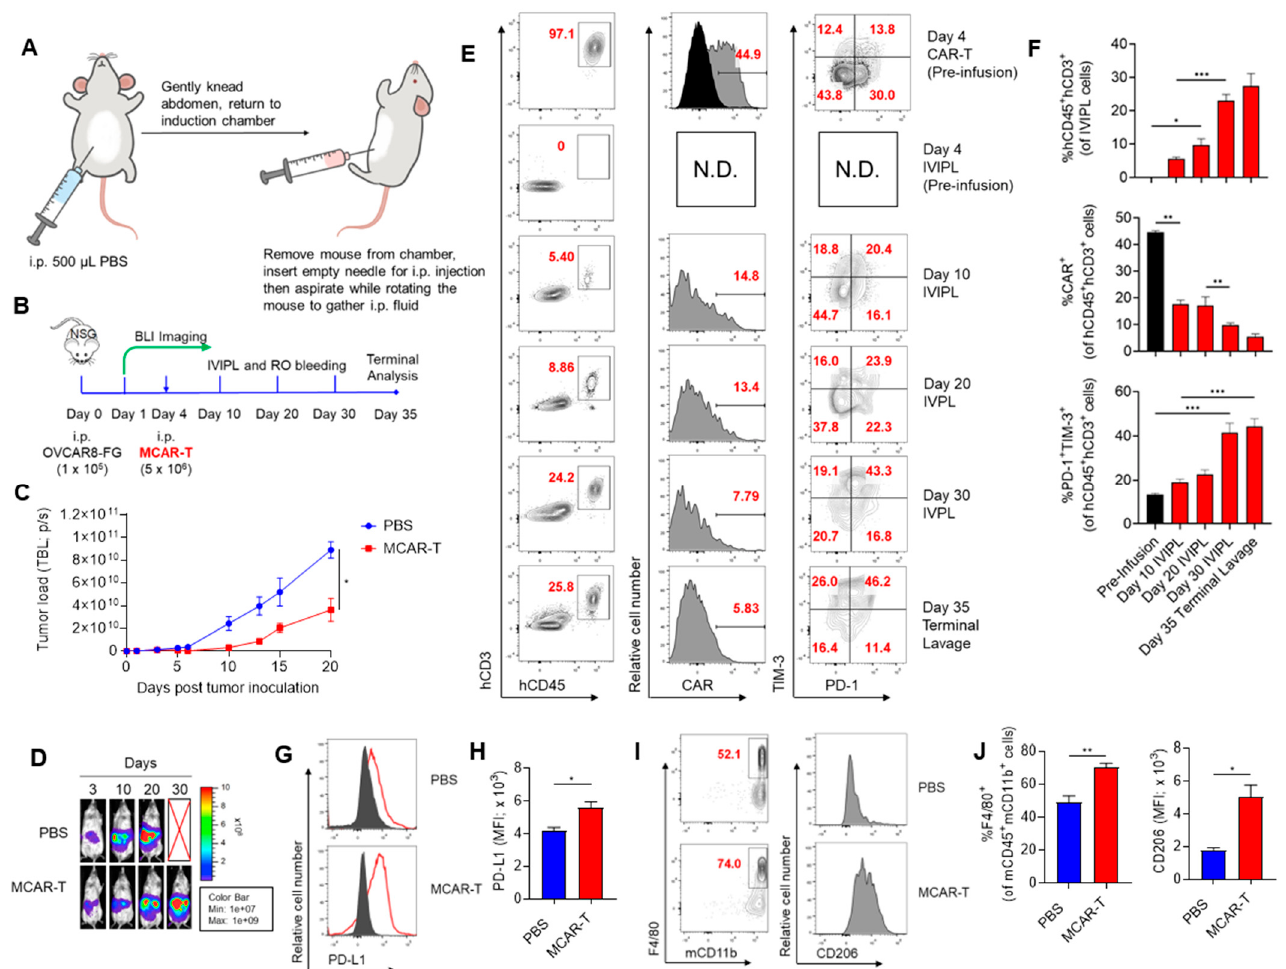
Figure 1. Design of in vivo intraperitoneal lavage (IVIPL) and its usage in studying CAR-T therapy. ( A ) Schematic representation of IVIPL. Mice are injected i.p. with 500 uL PBS and the abdomen is gently kneaded. Peritoneal fluid is then aspirated from the mice by inserting a needle while the mouse is held supine to avoid organs and rotating the mouse to allow fluid buildup in the lower abdomen. ( B – J ) Studying the in vivo antitumor efficacy of mesothelin-targeting CAR-T cells in an OVCAR8-FG human ovarian cancer xenograft NSG mouse model. ( B ) Experimental design to monitor CAR T cells using IVIPL in an ovarian cancer model. ( C ) Tumor growth curve (n = 4 per group) and representative bioluminescence images ( D ). ( E ) FACS plots showing the change in CAR-T cell phenotype over time, summarized in ( F ). hCD3 + hCD45 + are gated on live IVIPL cells, CAR and PD1/TIM-3 plots gated on hCD45 + CD3 + cells. Black bars indicate pre-infusion in vitro MCAR-T cells. ( G ) FACS plots showing the change in tumor PD-L1 expression between treatment groups on day 20, summarized in ( H ). Gated on GFP + tumor cells. ( I ) FACS plots showing the change in tumor- associated macrophage accumulation and phenotype on day 20, summarized in ( J ). Left FACS plots gated on mCD45 + cells, right FACS plots gated on mCD45 + mCD11b + F4/80 + cells. * p < 0.05; ** p < 0.01; *** p < 0.001. We first tested administering different volumes of 1X PBS i.p. into tumor-free NSG mice. At a volume of 100 uL, it was difficult to aspirate any i.p. fluid. Increasing the vol- ume to 200 uL allowed the aspiration of single digit uL of i.p. fluid, and the volume of aspirate obtained continued to increase with larger volumes of PBS injected. By adminis- tering 500 uL PBS, 50 uL i.p. fluid was reliably aspirated, and 500 uL injections of PBS were used for subsequent IVIPLs. IVIPL did not negatively affect the health of the mice as determined by observation, and, in fact, i.p. saline buffer injection is commonly used to help hydrate mice [24]. The mice remain under isoflurane anesthesia throughout the IVIPL procedure to limit the suffering of the animals. IVIPL isolated tens to hundreds of thousands of cells that can then be used for downstream analysis, such as flow cytometry. Preclinical i.p. tumor models are often used to study ovarian cancer (OC) and poten- tial treatments. To validate the application of IVIPL in xenograft OC models, we inocu- lated NSG mice i.p. with firefly luciferase and enhanced GFP (FG)-engineered high-grade serous ovarian cancer (HGSOC) cell lines, OVCAR8FG cells (Figure 1) or OVCAR3FG cells (Figure S3). Furthermore, as OVCAR8 and OVCAR3 cells express mesothelin (MSLN) and MSLN-targeted CAR-T (MCAR-T) cells are being actively tested in clinical and preclinical studies [25], we also studied the treatment of tumor-bearing mice with MCAR-T cells. A third generation CAR construct was used for these studies (Figure S1). IVIPL did not affect the growth of OVCAR8FG cancer nor cause discernable toxicity (Figure S2). Following the experiment shown in Figure 1B, OVCAR8FG tumor-bearing mice were treated with MCAR-T cells or PBS. MCAR-T cells significantly slowed tumor growth but were unable to clear OVCAR8FG tumors and all mice succumbed to disease (Figure 1C,D). As shown in Figure 1E-J, IVIPL allowed the recurrent monitoring of cells in the i.p. cavity of NSG mice. Monitoring of human CD45 + cells and GFP + tumor cells using flow cytometry revealed phenotypic changes in the therapeutic cell and cancer cell populations that may impact antitumor efficacy. Within the human CD45 + CD3 + popula- tion there was a decrease in the percentage of CAR-positive therapeutic cells, an upregu- lation of inhibitory receptors PD-1 and TIM-3, and a concomitant increase in PD-1 + TIM-3 + double positive cells. OVCAR8FG cells upregulated PD-L1 in the MCAR-T cell-treated group, indicating a potential mechanism for CAR-T cell immunosuppression. Although